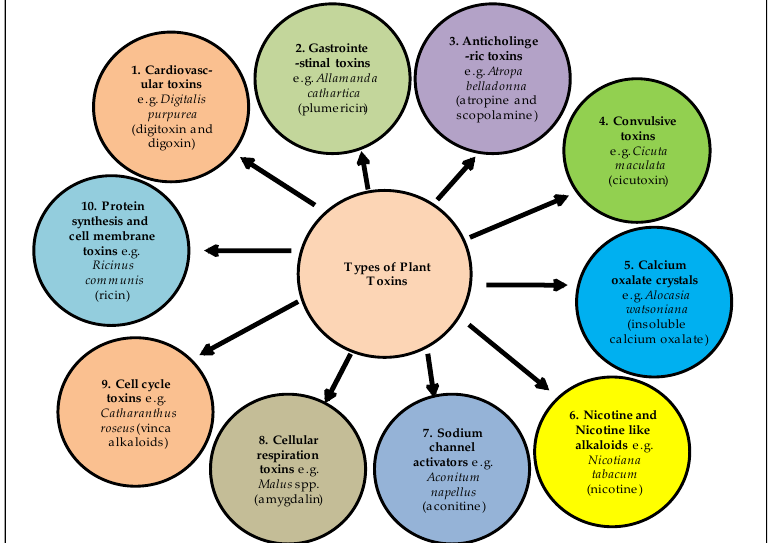
Figure 1. Types of plants toxins and their mode of actions.